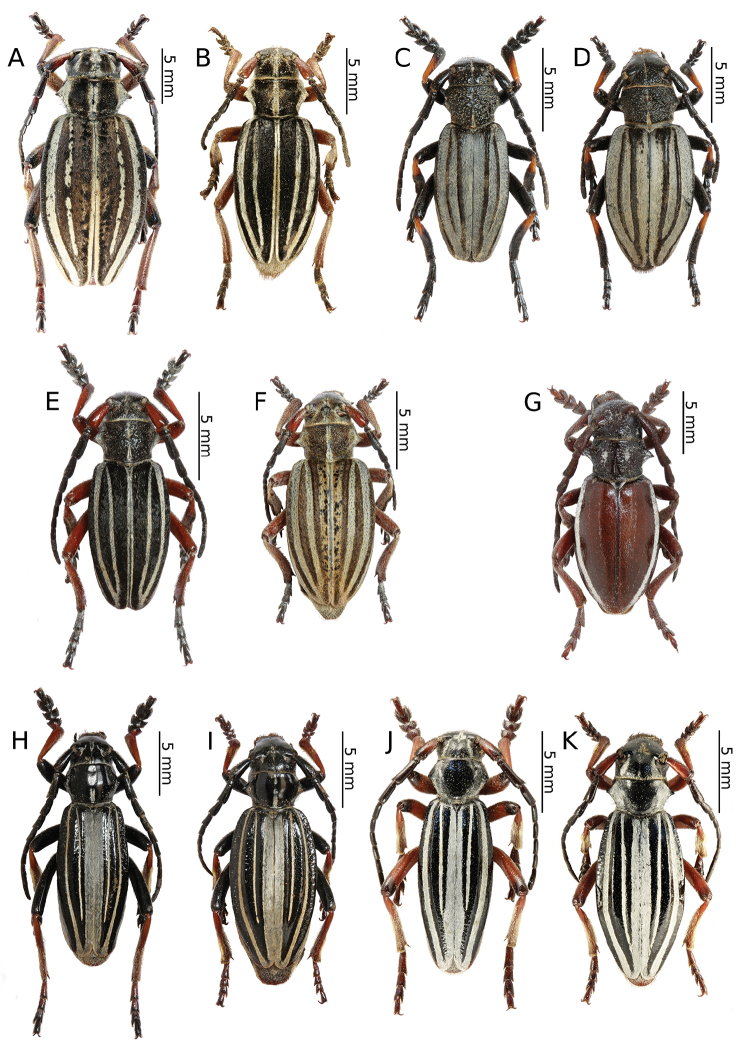
Photos of longhorn beetles specimens collected during the expedition to Kazakhstan in 2017: ADorcadionsongaricum (female) BDorcadionmorozovi (female) CDorcadionsemenovisemenovi (male) DD.semenovisemenovi (female) EDorcadionsokolowi (male) FD.sokolowi (female) GEodorcadioncarinatumcarinatum (male) HPolitodorcadionpolitumpolitum (male) IP.politumpolitum (female) JPolitodorcadionribbeibobrovi (male) KP.ribbeibobrovi (female).